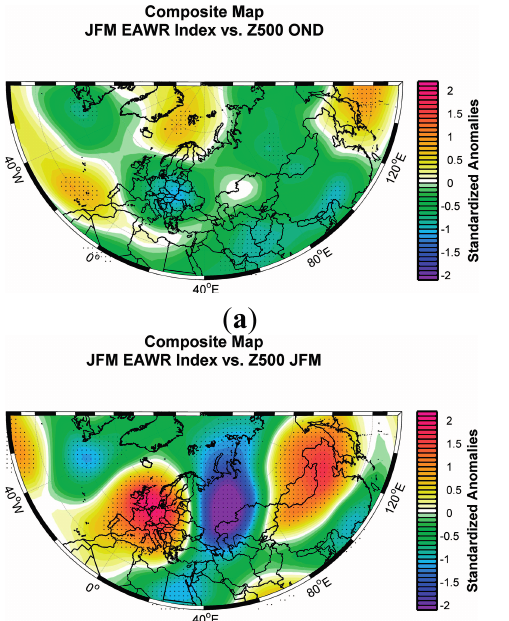
Figure 2. Geopotential Height at 500 hPa composite map ( difference between the averaged maps for which the EAWR JFM index was higher ( lower ) than 1 (–1) standard deviation ) for ( a ) October to December (OND); ( b) December to February (DJF) ( c ) January to March (JFM) and ( d ) February to April (FMA). Hatching displays areas at or over 95% sign significance level using a two tailed t-test